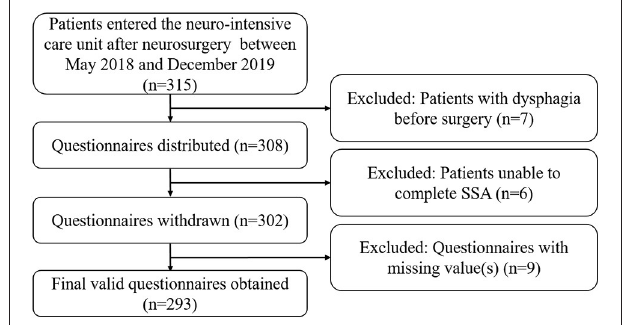
FIGURE 1 | Flowchart of the study design. NICU, neurointensive care unit; SSA, standardized swallowing